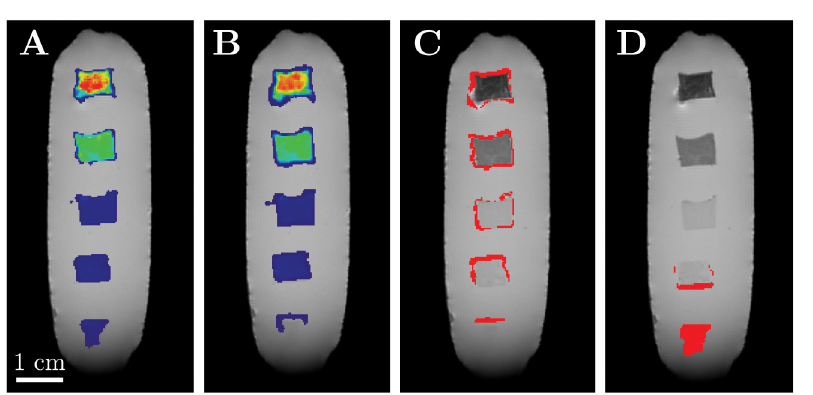
Fig 5. Overlay of the MRI magnitude data (grayscale) and SVM results (color-coded). A: Iron oxide concentration map for the training phantom. B: Iron oxide concentration map for the test phantom. The image was registered to the training phantom. C: False positive voxels ( ^ ¼ voxels that are falsely classi fi ed as containing labeled cells ) in the test phantom (data from B). D: False negative voxels ( ^ ¼ voxels that are falsely classi fi ed as not containing labeled cells ) in the test phantom (data from